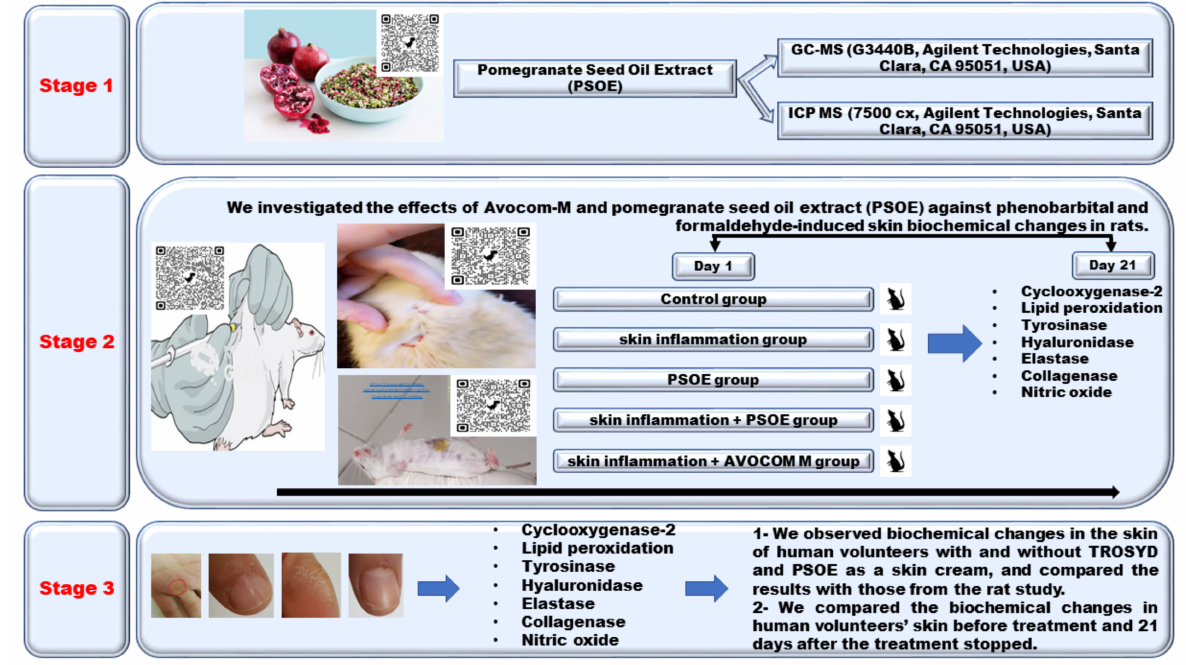
Figure 1. Experimental design